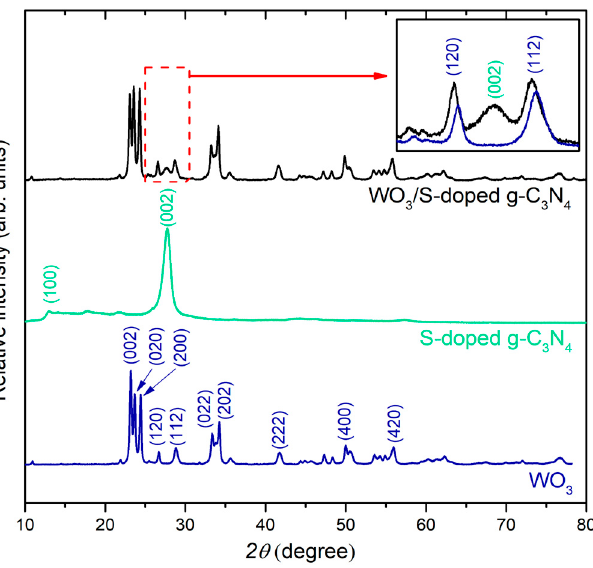
Figure 2. XRD patterns of WO 3 /S-g-C 3 N 4 and single components. The inset shows the zoom at diffractograms of WO 3 and WO 3 /S-g-C 3 N 4 in the range 2 θ = 25°–30°.